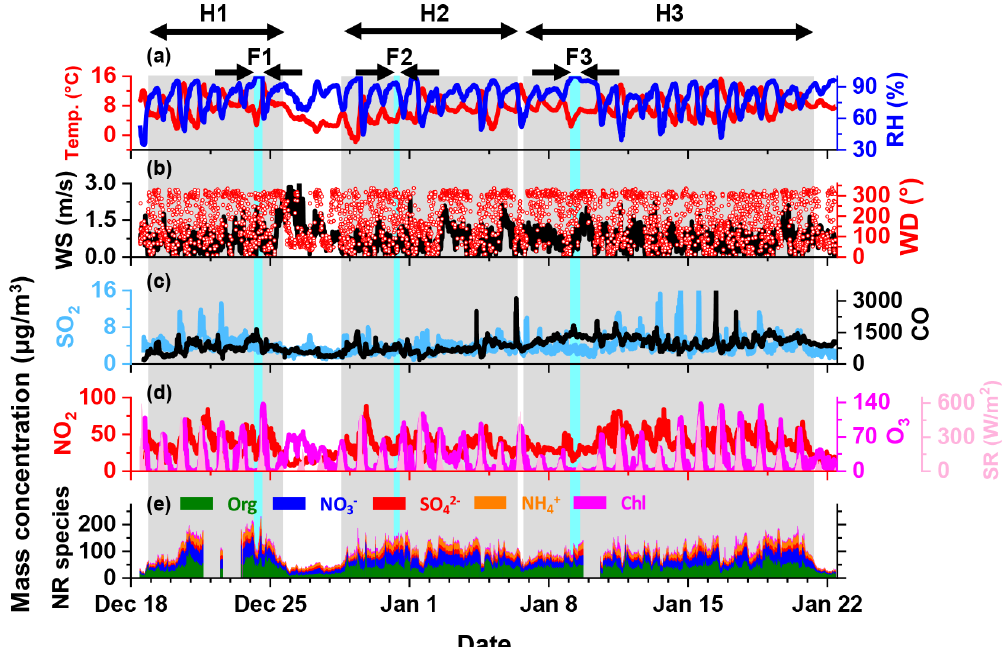
Figure 2. Time series of (a) relative humidity (RH) and temperature ( T ); (b) wind direction and wind speed; (c, d) CO, NO 2 , SO 2 and O 3 mass concentrations and solar radiation; and (e) mass concentration of organics, nitrate, sulfate, ammonium and chloride in NR-PM 2 . 5 . The grey-shaded areas represent the intervals of H1, H2 and H3, respectively. The light-blue-shaded areas represent the intervals of F1, F2 and F3,